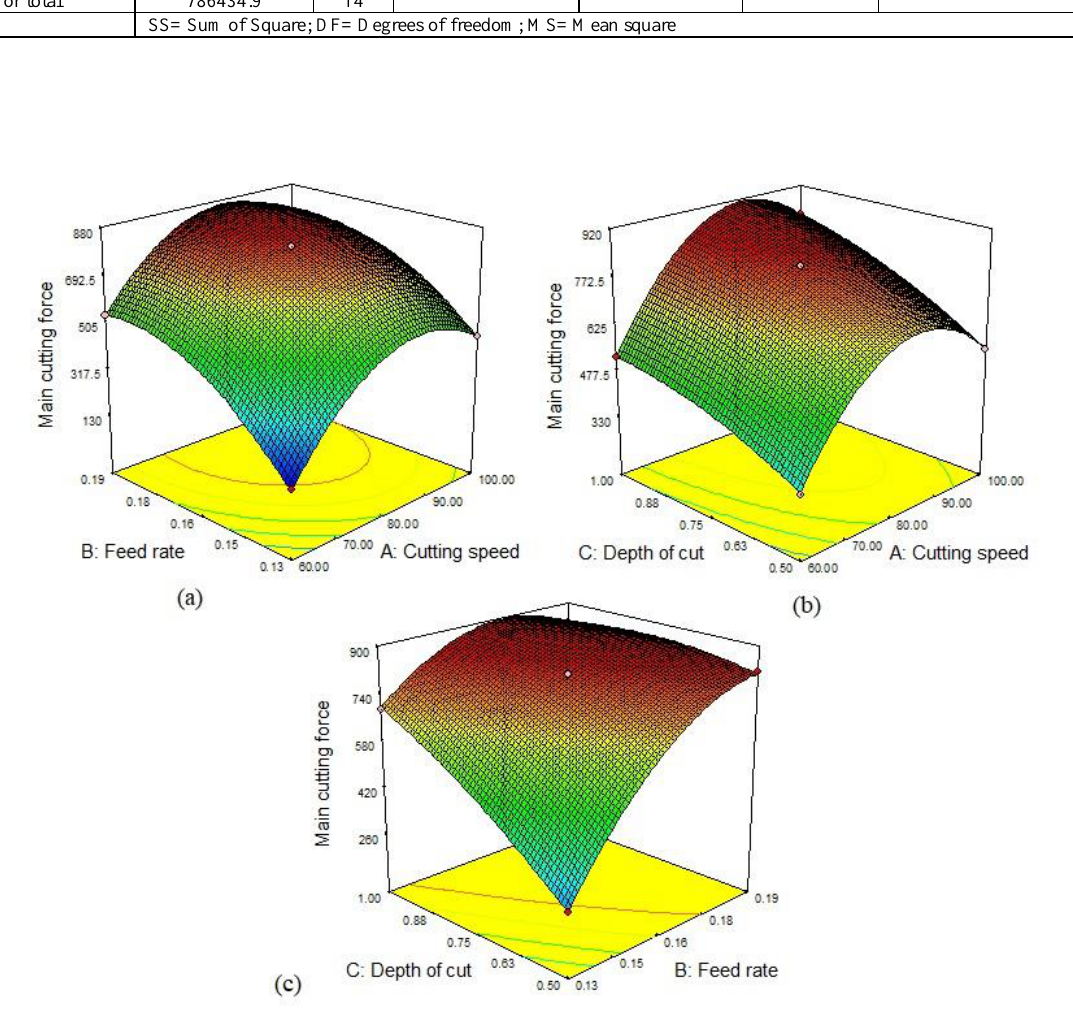
Figure 7. (a-c) esteemed response surface plot for main cutting force (F z